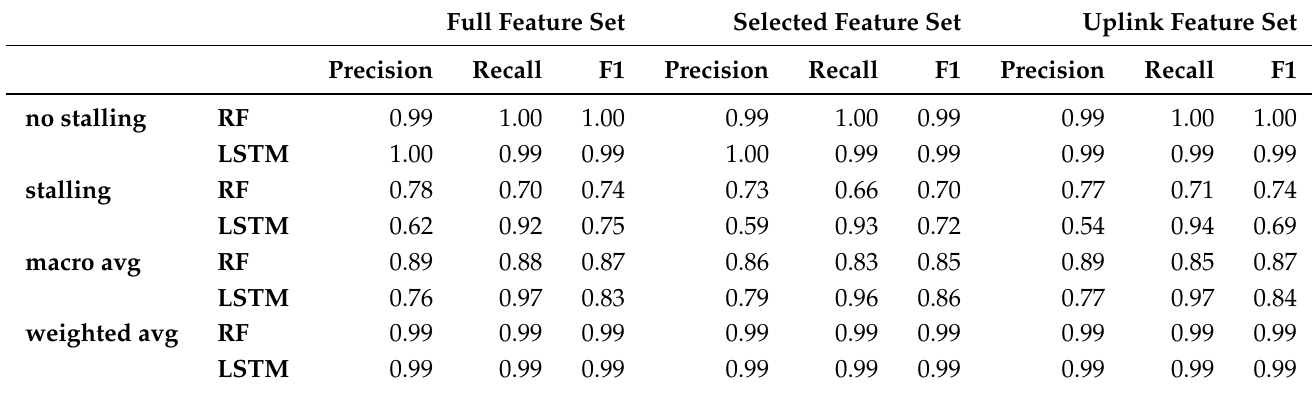
Table 16. Stalling prediction